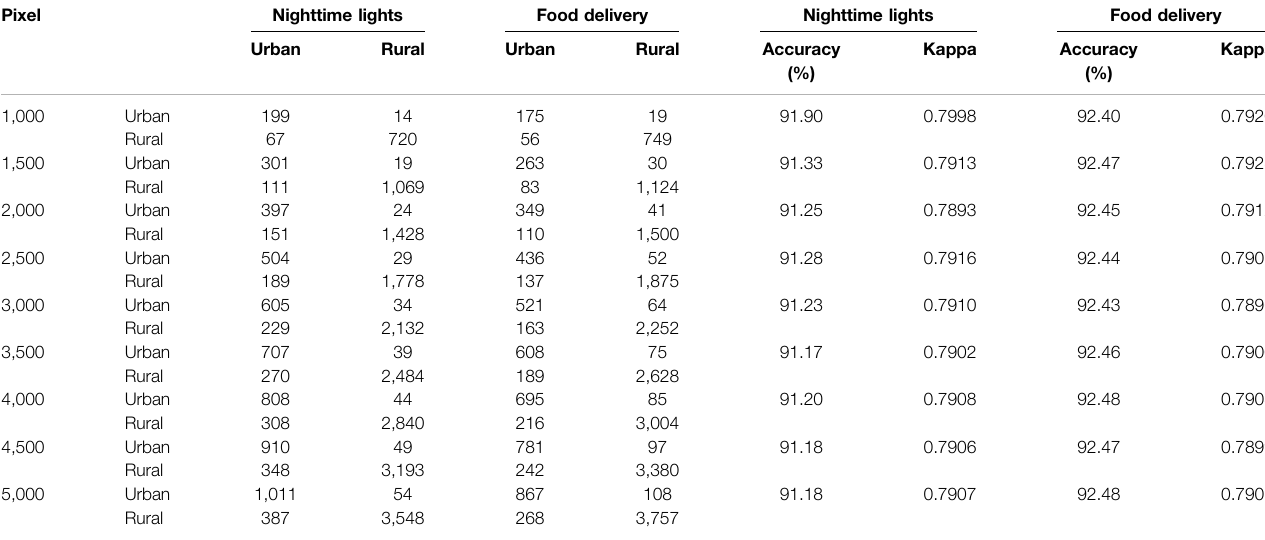
TABLE2| Accuracyassessmentoftheconfusionmatrix(Randomveri fi cationpointsareusedtoverifytheresultsofurbanandruralspatialareaofNTLdataandfooddelivery data identi fi cation. Among them, the accuracy of the selected 1,000 – 5,000 random veri fi cation points show an obvious upward and downward trend, and the speci fi c results are shown in the